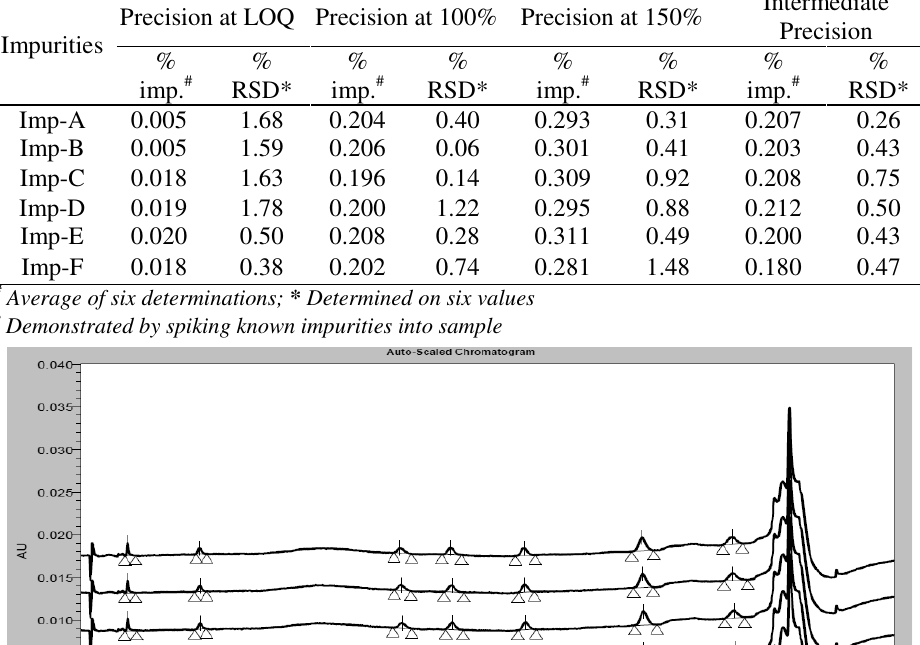
Precision at LOQ Precision at 100% Precision at 150%